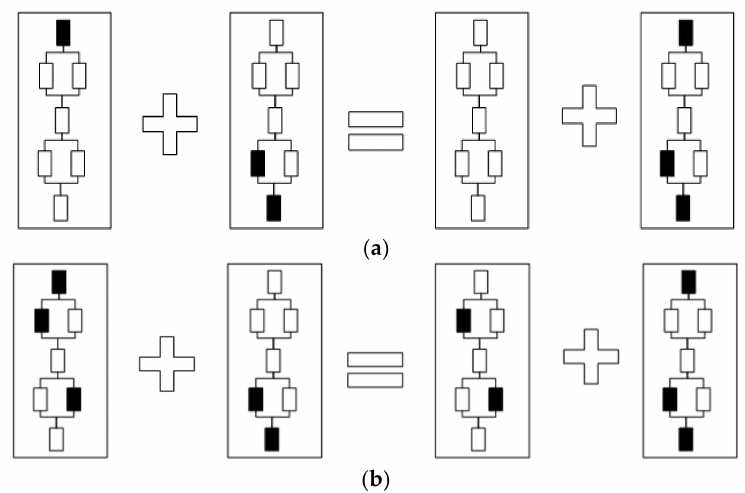
Figure 5. Effect to be concerned when deducing the merging operator of two poles: ( a ) Standby effect of AC filters; ( b ) Recovery effect of converter